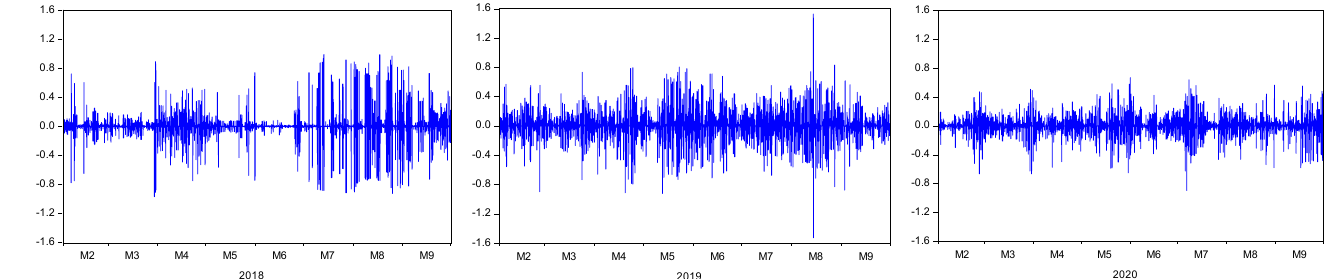
Figure 2. Logarithmic returns of the electricity spot prices for February–September of 2018–2019–2020.